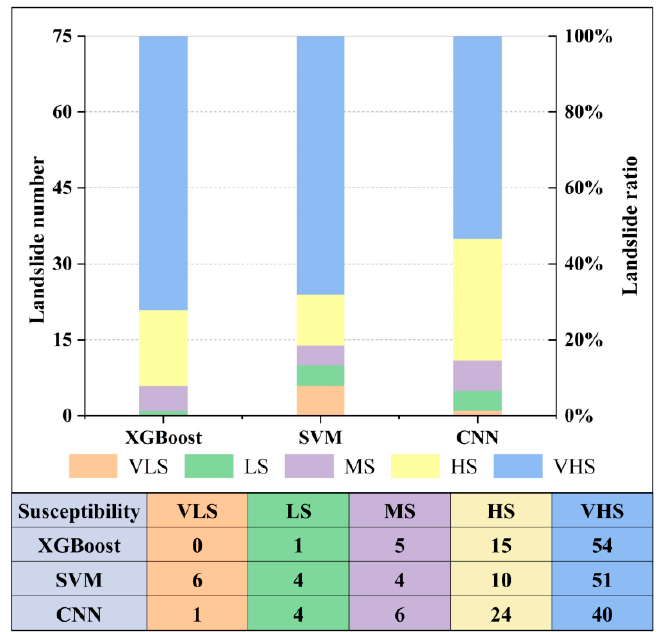
Figure 10. Comparison of landslide susceptibility statistics of the three algorithms. See Figure 8 for the meaning of the abbreviations.